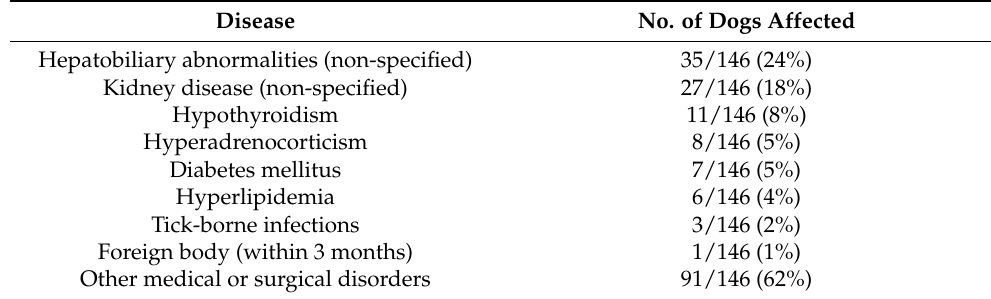
Table 4. Comorbidities reported in returned survey data from dogs with a serum cPLI concentration ≥ 400 µ g/L.